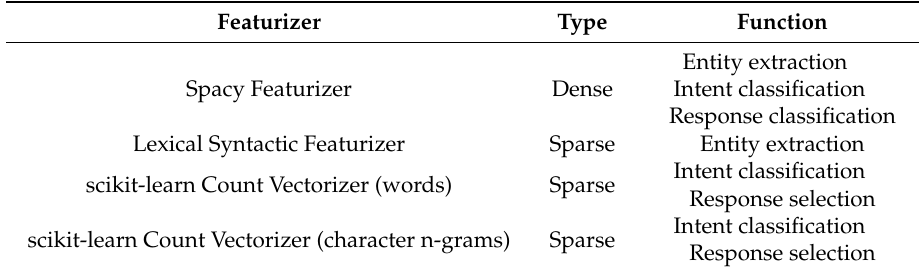
Table 5. Used featurizers and related